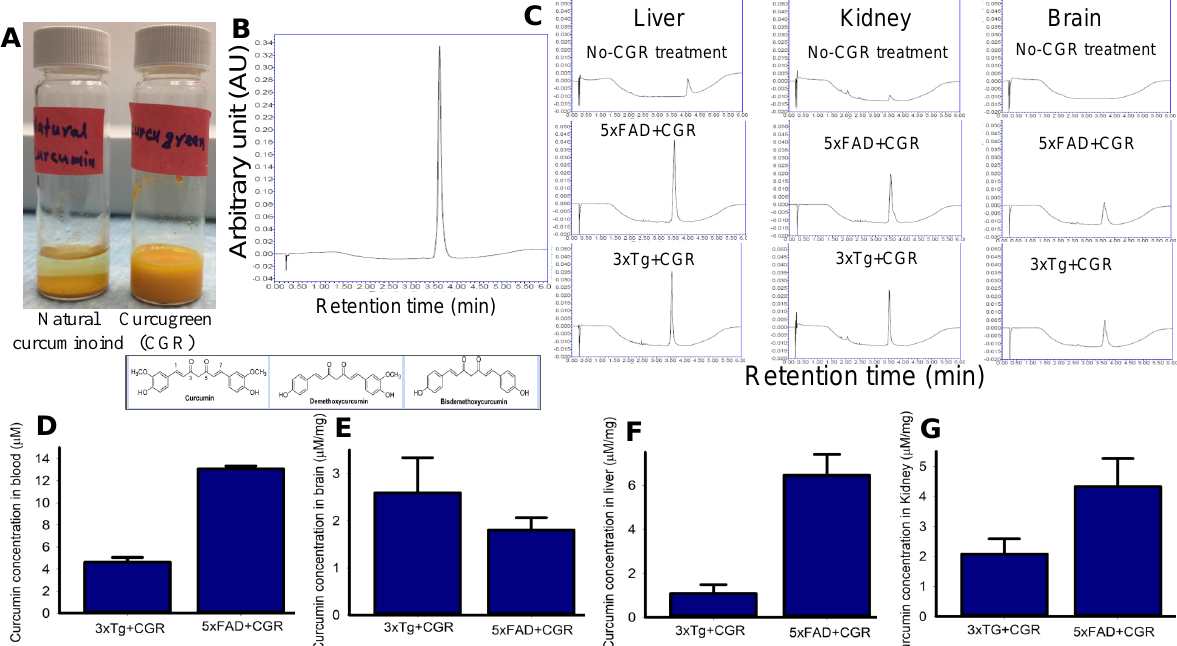
Figure 1. Curcumin levels in different tissues in 3xTg and 5xFAD mice after treatment with curcugreen. The 3xTg and 5xFAD mice were treated with curcugreen (100 mg/kg), every other day, orally, for 2 months and the blood, liver, kidney and brain tissues were collected, extracted and about 10 µ L of filtrate was injected to UPLC for free Cur measurement. ( A ) Natural curcuminoids and CGR were dissolved in distilled water. Note that the CGR was dissolved completely in water, whereas natural curcuminoids appeared to precipitate. ( B ) Standard Cur (20 µ M) peak and retention time when injected to UPLC. ( C ) Representative peak of Cur in CGR-treated 3xTg and 5xFAD mice from blood, liver, kidney and cerebellum. Note that no peak was observed in CGR-untreated mice tissues (upper panel), whereas CGR-treated mice tissues showed Cur peaks comparable to standard Cur peaks with similar retention time. ( D – G ) Amount of free Cur in blood ( D ), cerebellar tissue ( E ), liver ( F ) and kidney ( G ) of 3xTg and 5xFAD mice treated with CGR. The values were expressed and mean ± SEM from 4–5 mice in each